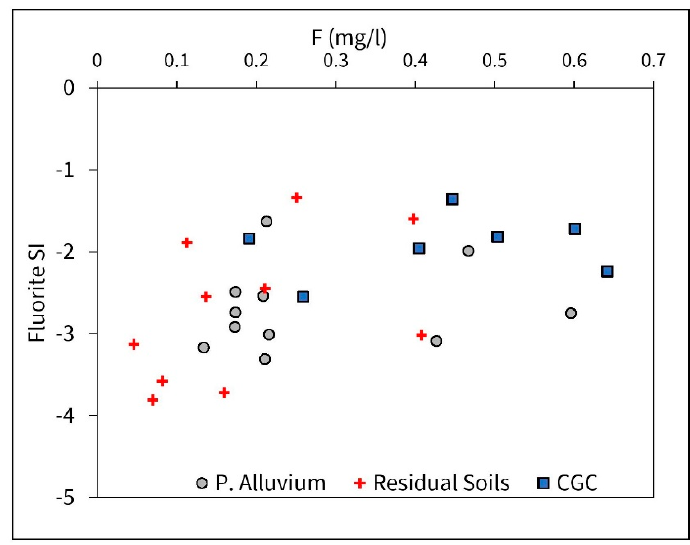
Figure 10. SI (fluorite) vs. groundwater F concentrations in the region.